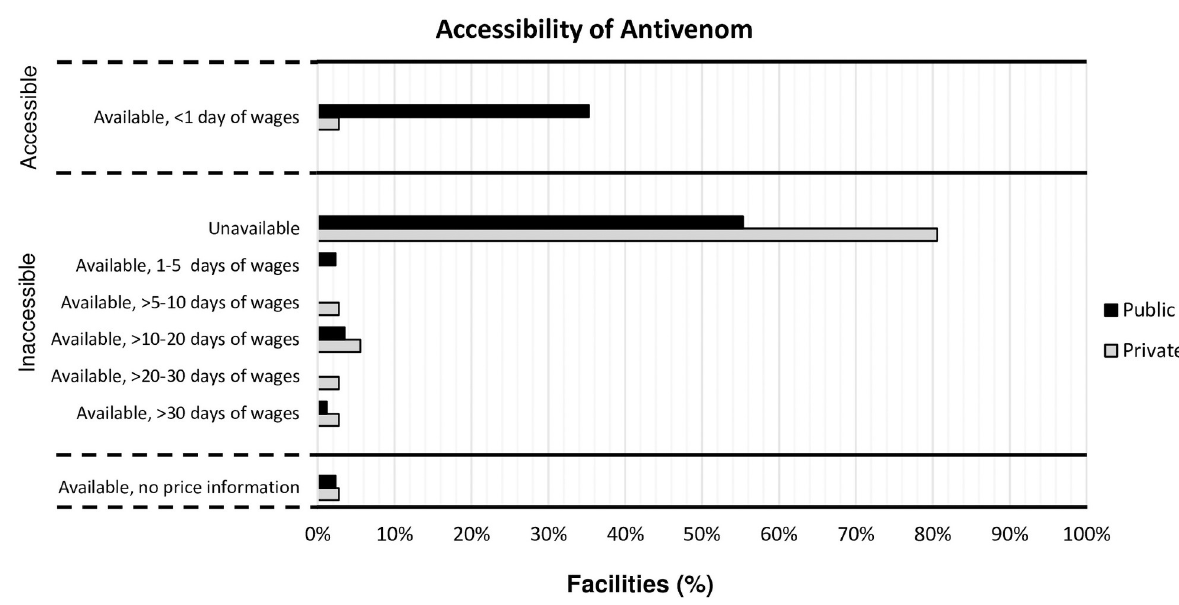
Fig 2. Accessibility of antivenom, per